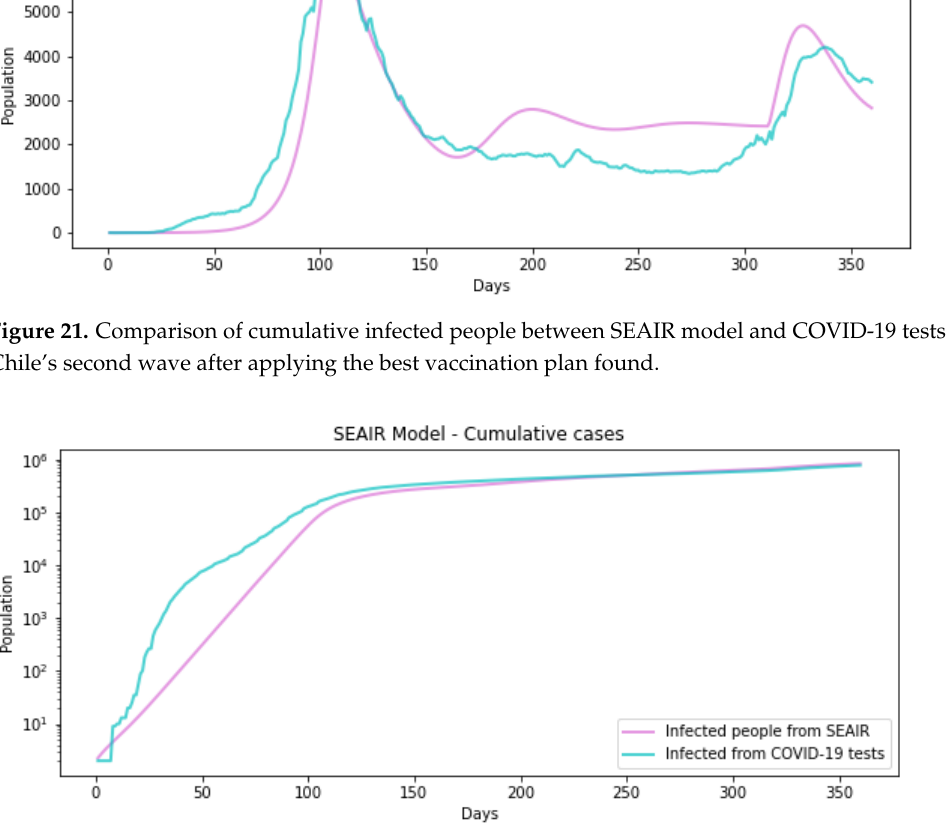
Figure 22. Comparison of cumulative infected people between the SEAIR model and COVID-19 tests in Chile’s second wave after applying the best vaccination plan